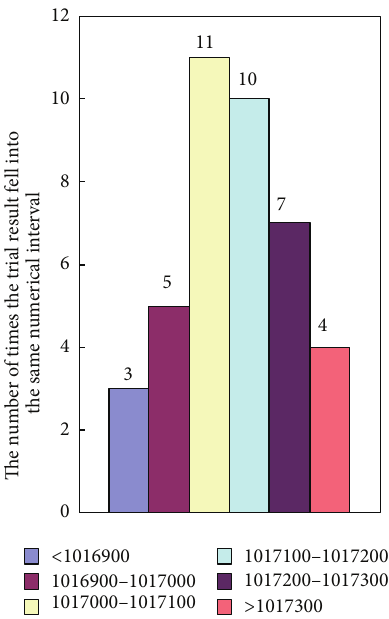
Figure 6: Distribution of the results of the 40 independent trials for test system